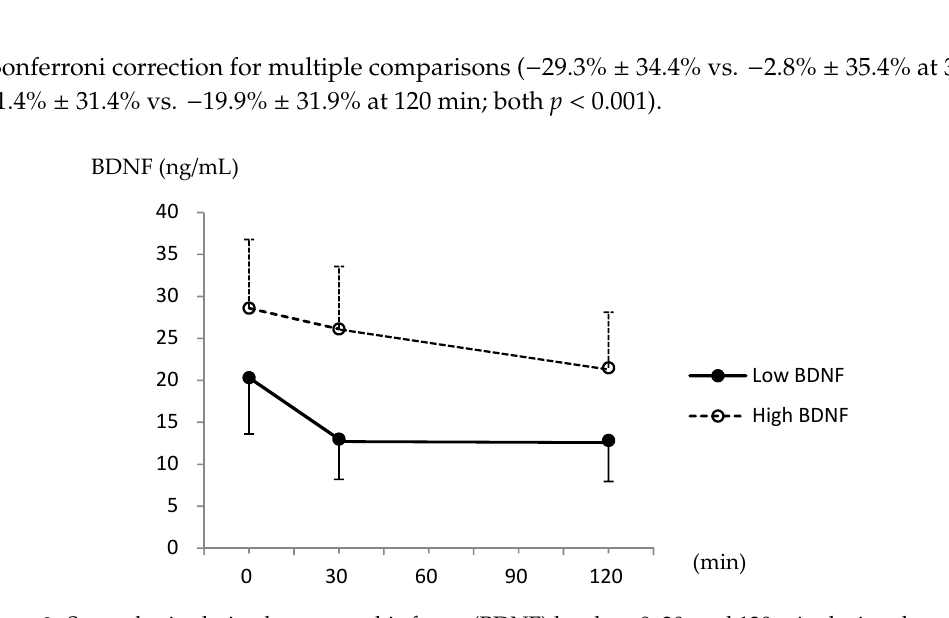
Figure 3. Serum brain-derived neurotrophic factor (BDNF) levels at 0, 30, and 120 min during the oral glucose tolerance test.